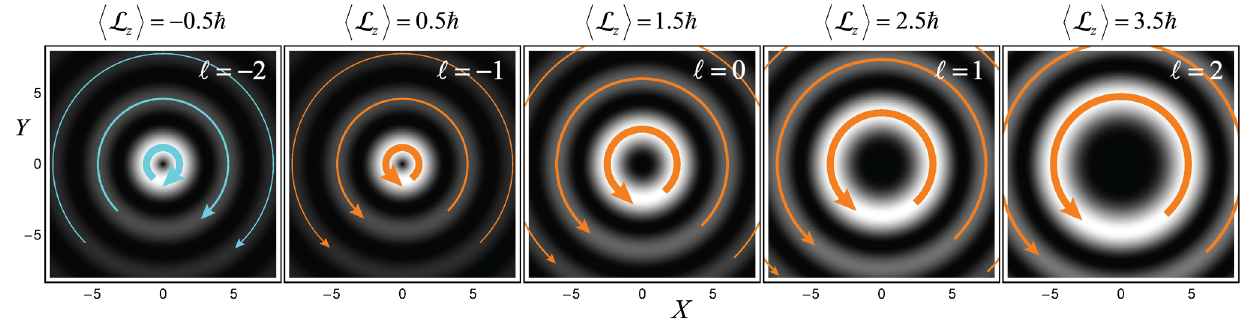
FIG. 4. Transverse probability-density distributions and azimuthal currents, Eqs. (22), for the Aharonov-Bohm Bessel modes (20) with different OAM quantum numbers ‘ in the presence of a magnetic-flux line of strength (cid:7) ¼ (cid:1) 1 : 5 . The free-space symmetry between modes with the opposite ‘ (see Fig. 2) is significantly broken here by the magnetic flux (cid:7) . The probability currents generate kinetic OAM (23), which is shown above the panels. The dimensionless coordinates X ¼ (cid:3)x and Y ¼ (cid:3)y are